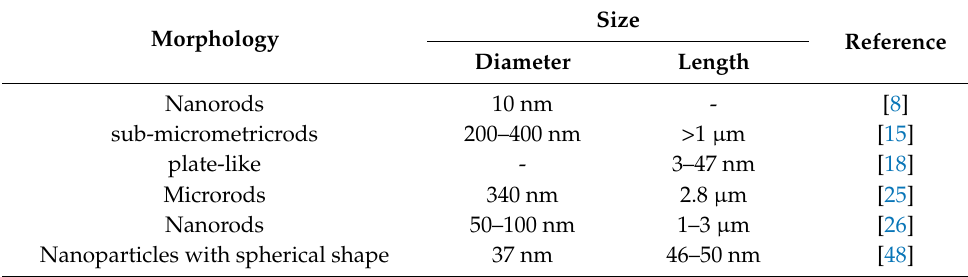
Table 2. The morphology and size of hydrated CoMoO 4 crystals obtained by the co-precipitation method.